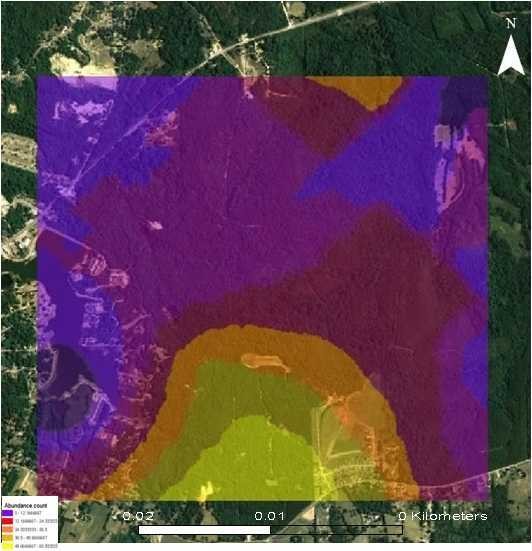
Predicted Northern Cardinal abundance count data in the Tuskegee study site using an Ordinary kriging algorithm.